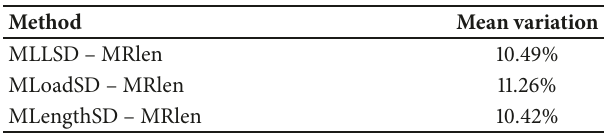
Table 1: Length variation.